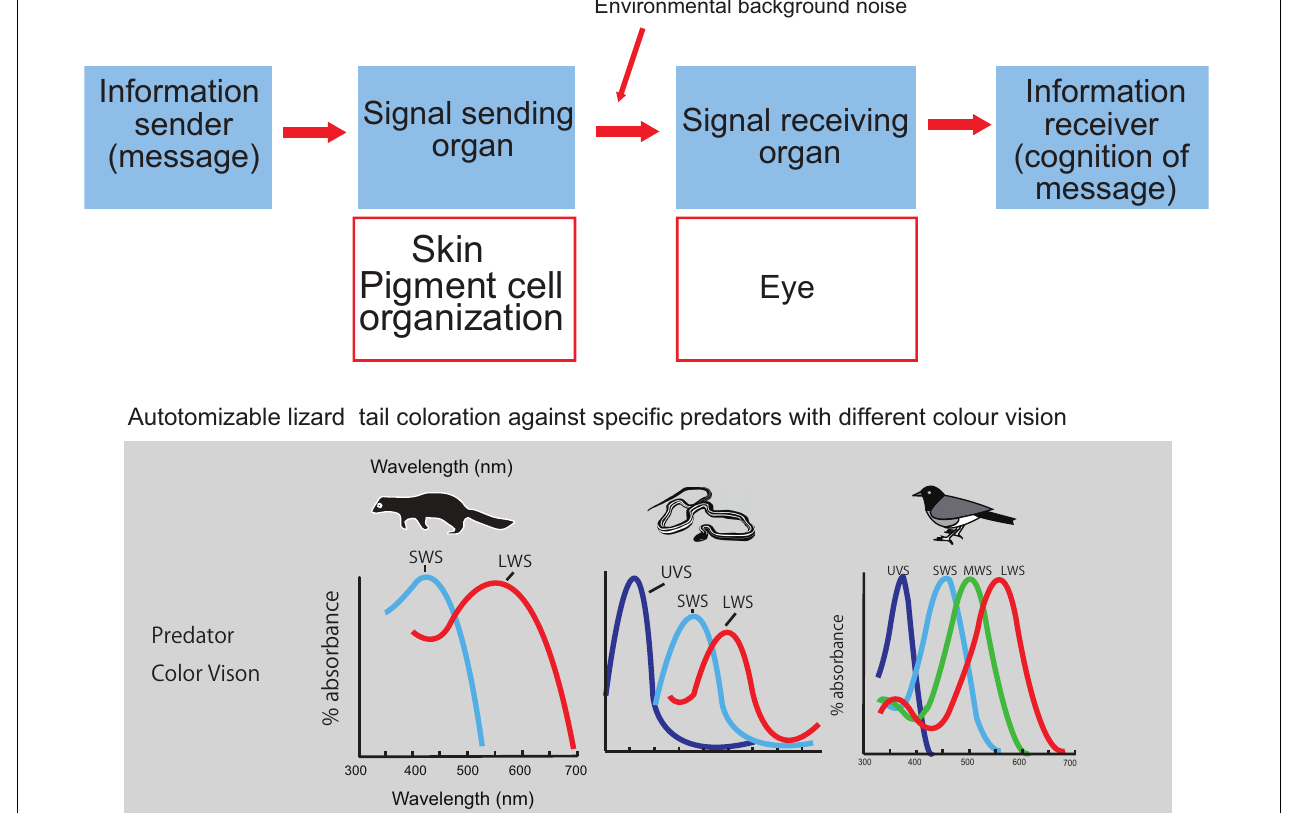
2013; Brejcha et al., 2019). These layered organization of pigment cells (xanthophores on top, iridophores in the middle, and melanophores on the bottom) is conserved in zebrafish